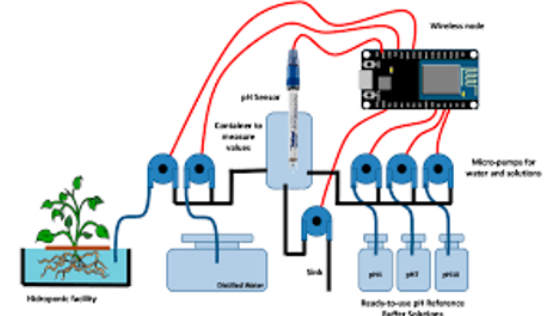
Fig 5. Hydroponic Precision Farming